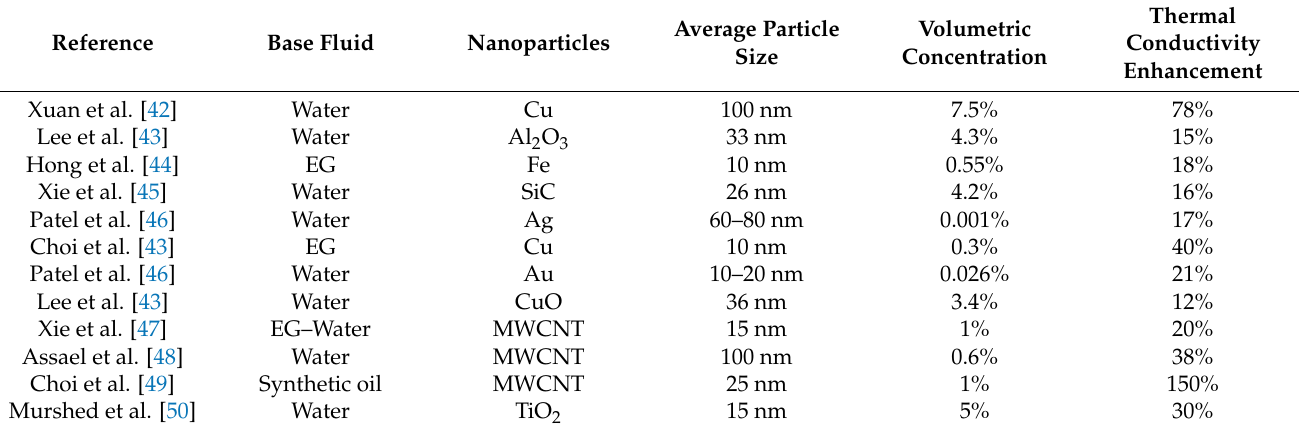
Table 1. Summary of comparison of thermal conductivity of metallic and non-metallic oxide nanofluids.